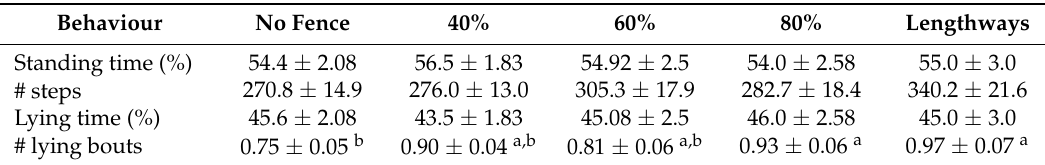
Table 1. Mean activity ( ± standard error) within 2 h periods of six cattle with different virtual fence inclusion zones *